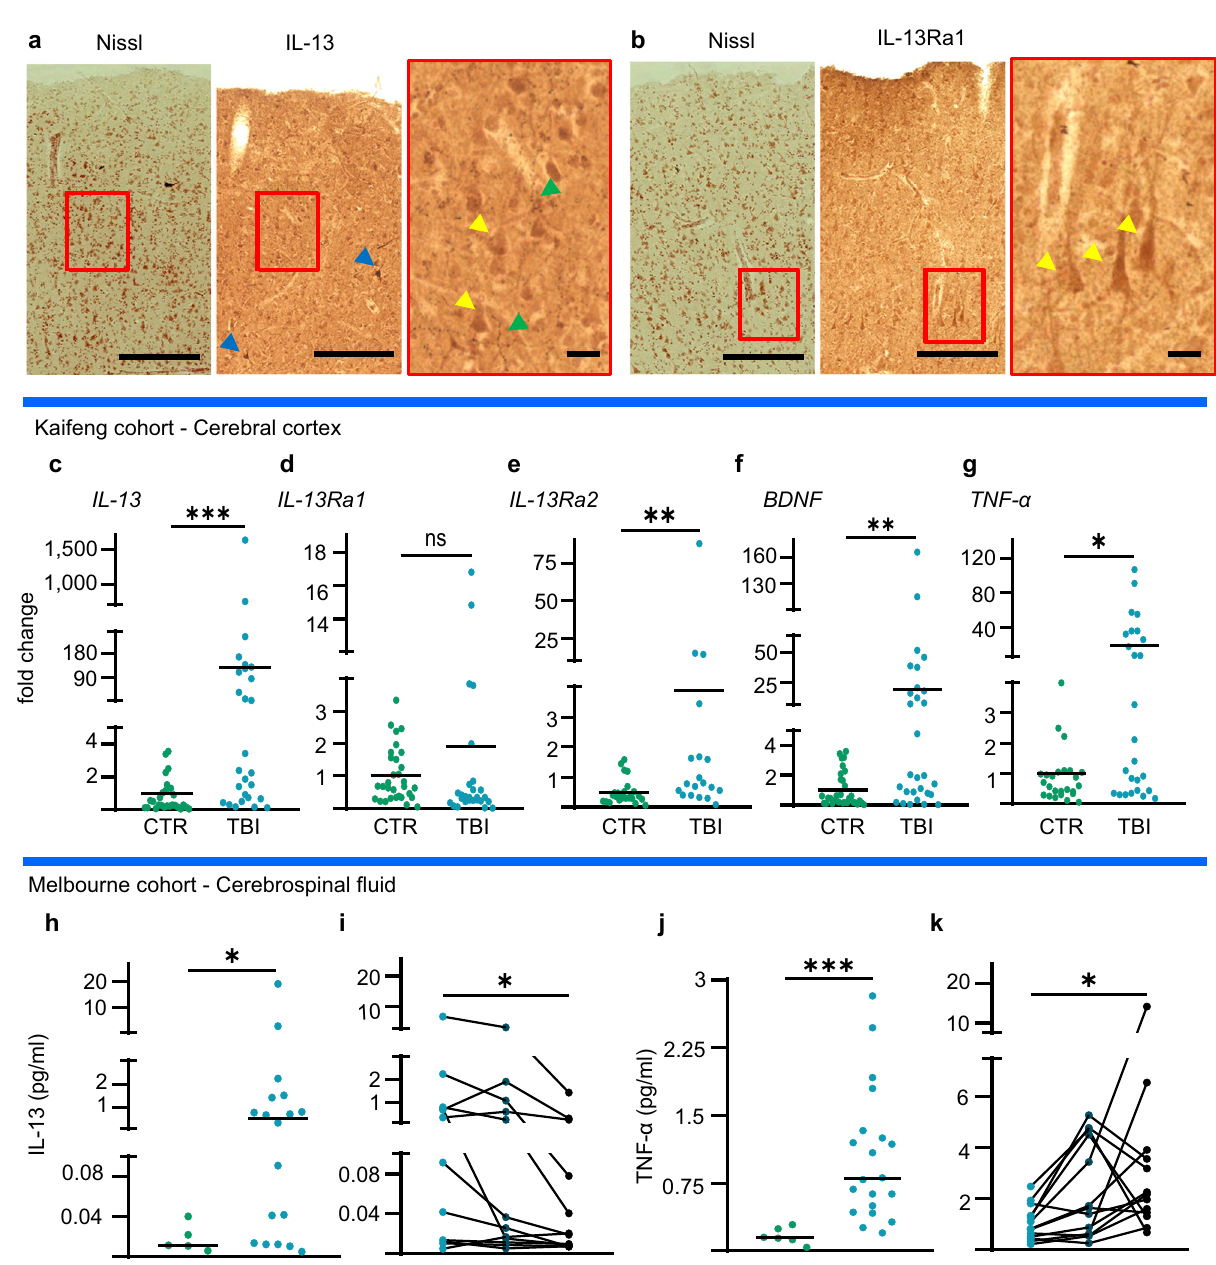
Fig.9|IL-13isexpressedinthehumanbrainandisupregulateduponTBIinthe human cortex and CSF. a Darrow red Pigment-Nissl and Immunohistochemistry for IL-13 shows moderate, high and very high-expressing neuronal populations in human post-mortem cortical tissue. N =3. b Darrow red Pigment-Nissl and Immu- nohistochemical staining of IL-13Ra1 shows a large number of neurons across all corticallayersofpost-mortemcorticaltissue. N =3. a , b Scalebaroverview:100 μ m, scale bar insert: 10 μ m. c – g Signi fi cant upregulation of the mRNA for IL-13 ( p =0.0002), IL-13Ra2 ( p =0.0021), BDNF ( p =0.0015) and TNF- α ( p =0.0160), but not of IL-13Ra1 ( p =0.0998), in human cortical tissue samples resected after trau- matic brain injury vs controls from elective surgery. (RT-qPCR). CTR N =34;